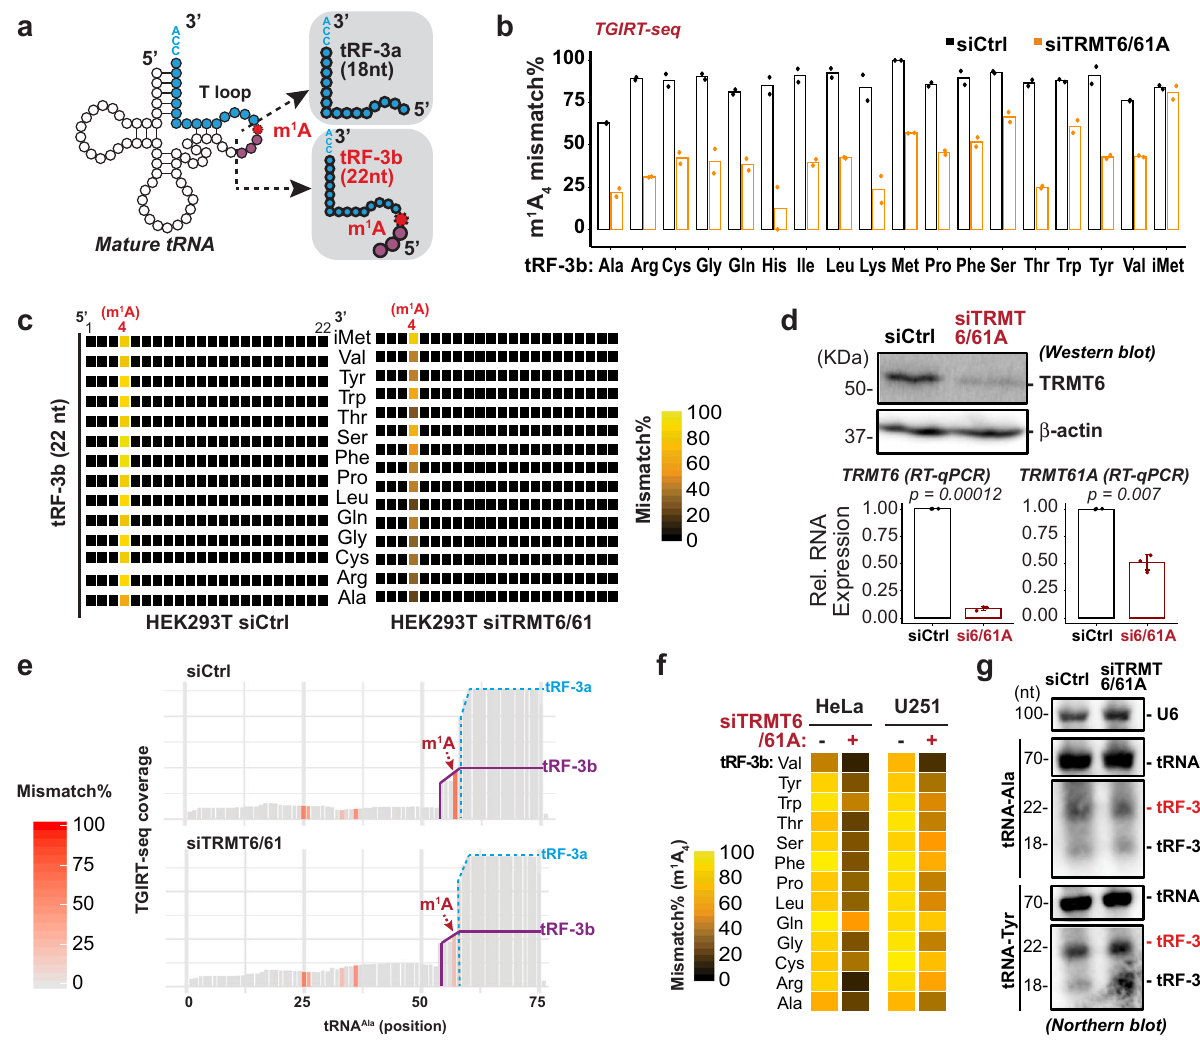
Fig. 3 m 1 A on 22-nucleotides 3 ′ tRNA fragments is dependent on TRMT6/61A. a Scheme of 3 ′ tRNA fragments (tRF-3s) that are derived from 3 ′ end of mature tRNAs. tRF-3b indicates 22-nt tRF-3s, and tRF-3a indicates 18-nt tRF-3s. b – e m 1 A mismatch on 22-nt tRF-3bs are globally regulated by TRMT6/ 61A. b , c Mismatch rate is calculated for the A4 position on tRF-3bs, based on TGIRT-seq of two independent knock-down experiments in HEK293T. d Knock-down ef fi ciency is con fi rmed by western blot and RT-qPCR. RT-qPCR data was represented as mean ± SD ( p value based on two-tailed paired student ’ s t test from three independent knock-down experiments). e Coverage plot of all tRF reads mapped on the parental tRNA Ala shows decrease of m 1 A of tRF-3b but not tRF-3 abundance (TGIRT-seq in HEK293T, one replicate shown as example). f m 1 A mismatch on A4 position of tRF-3b is also decreased by siTRMT6/61A in HeLa and U251, based on TGIRT-seq. g Northern blot con fi rms detection of both tRF-3a and tRF-3b isoforms, which are not altered by siTRMT6/61A in HEK293T. Full-length tRNA Ala , tRNA Tyr and U6 are probed as a loading control. See also Supplementary Fig. 3. Source data are provided as a Source Data fi